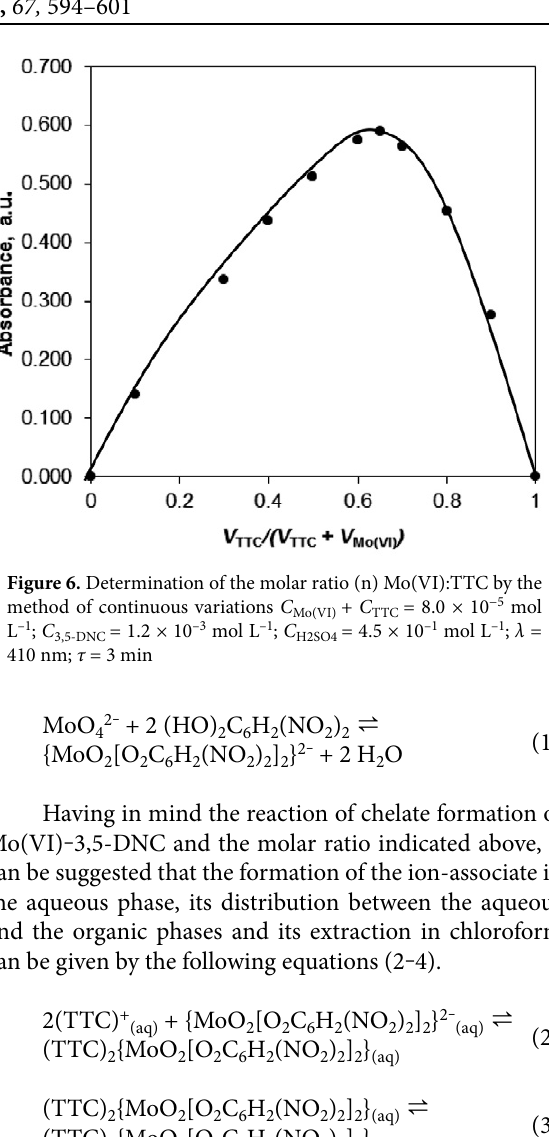
Figure 5. Determination of the molar ratio (n) Mo(VI):3,5-DNC by the method of Asmus C Mo(VI) = 1.6 × 10 ‒5 mol L –1 ; C TTC = 2.4 × 10 ‒4 mol L –1 ; C H2SO4 = 4,5 × 10 –1 mol L –1 ; λ = 410 nm; τ = 3 min